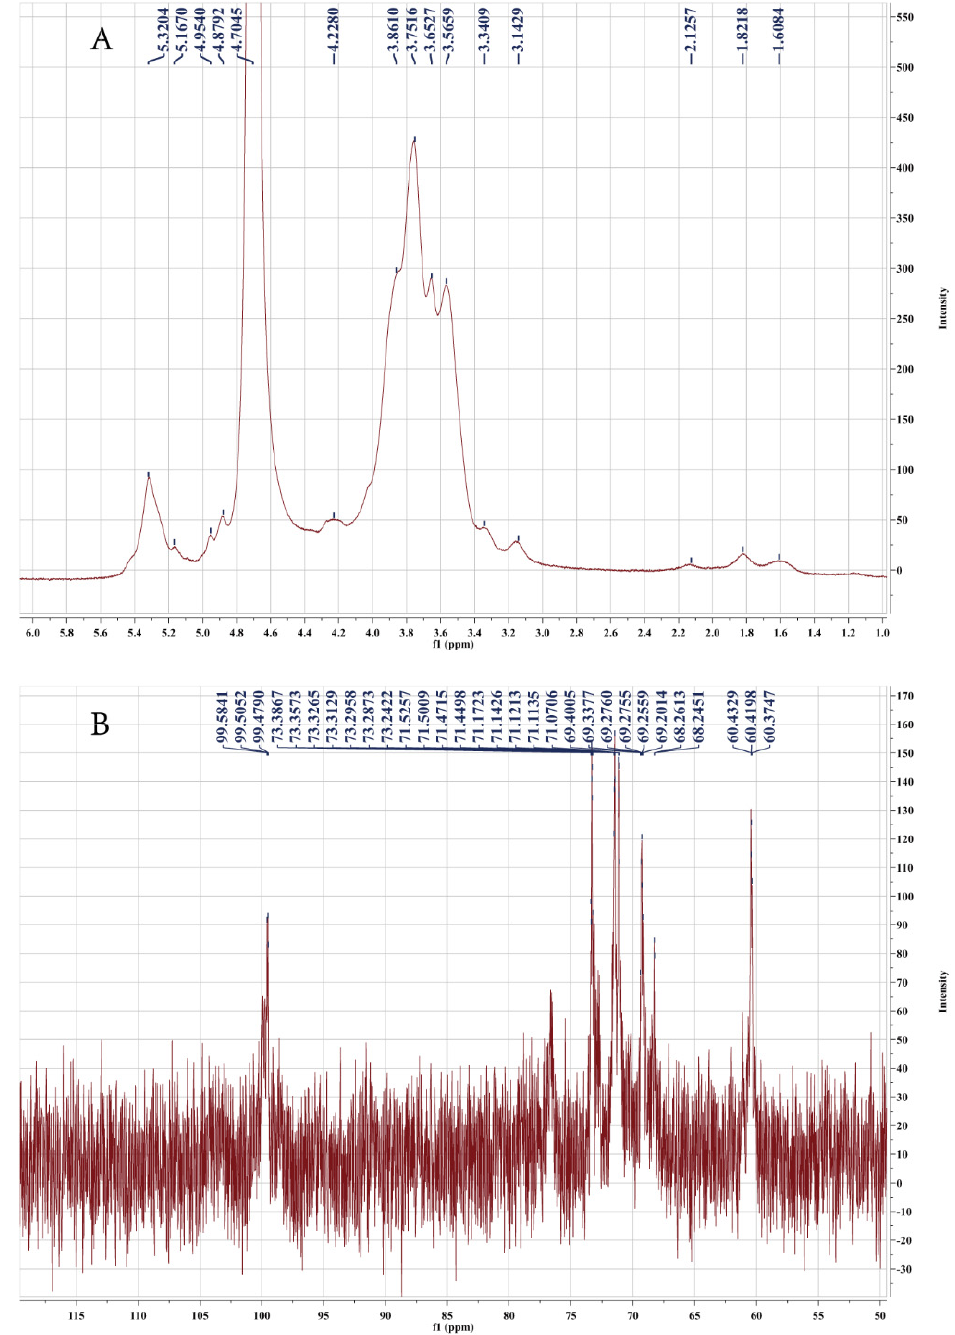
Figure 3. ( A ) 1 H and ( B ) 13 C NMR spectra of PF40.